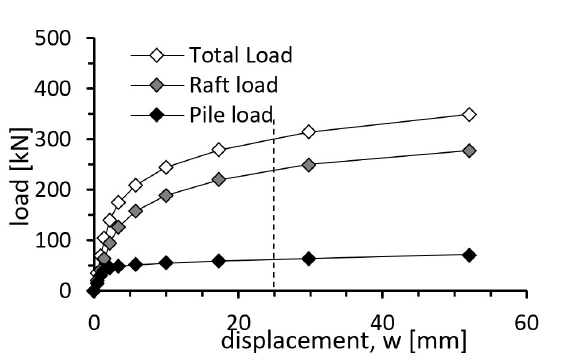
Figure 9. Load-settlement curves for case 2 - L=3m;